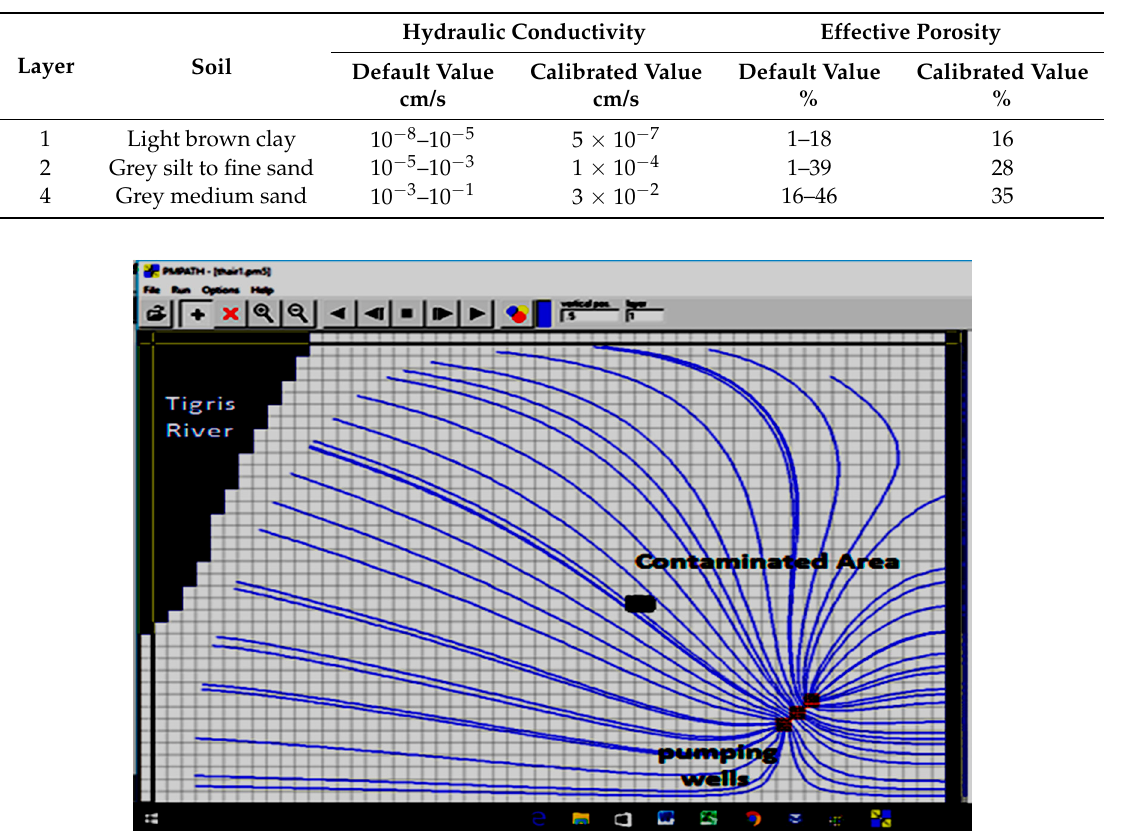
Figure 4. Groundwater flow directions for Scenario 2. Water 2018 , 10 , x FOR PEER REVIEW